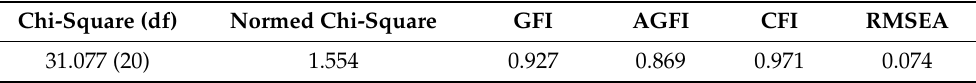
Table 3. Fatigue Model Fit.